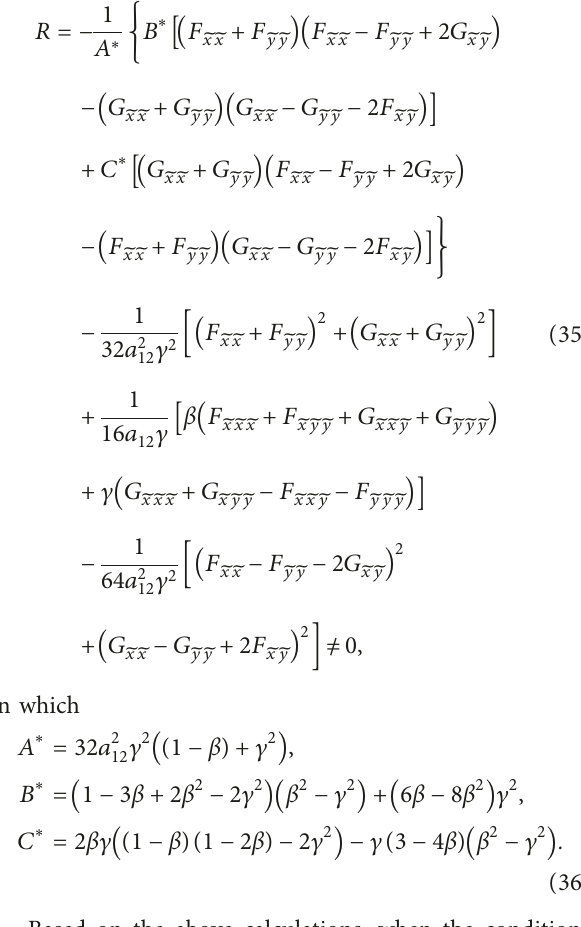
exist. Zone II and III represent no bifurcation and bi- furcation area around the fixed point E ∗ . And Figure 2(b) shows the bifurcation diagram when I � 1 . 6 and e � 0 . 2. The Hopf bifurcation point is not suitable here with a time step e not small enough, while the calculated Neimark–Sacker bifurcation point is more correct compared with the sim- ulated bifurcation point. This difference can be shown in Figure 2(d): e cannot be equal to 0.2, but in the discrete model, when e � 0 . 2, Neimark–Sacker bifurcation occurs and drives the system from stable fixed point to quasipe- riodic dynamics. When time delay τ � 3 satisfy both τ > τ N − S and τ > τ , the dynamics of the continuous model (with Hopf e � 0 . 01 as in [46]) and the discrete model ( e � 0 . 2)